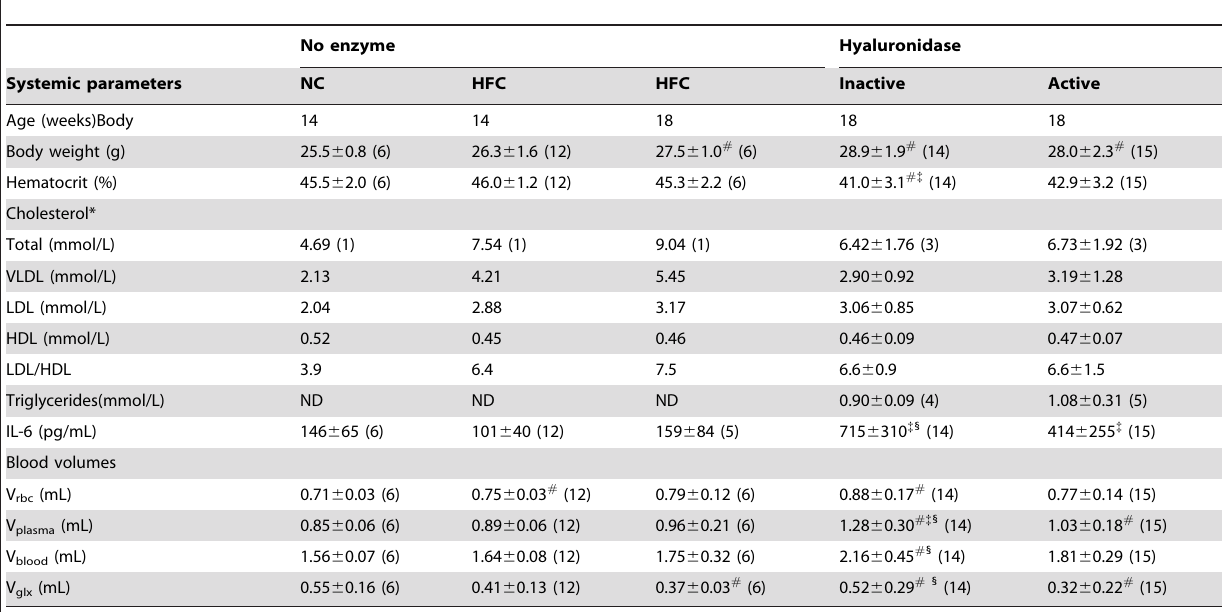
Table 1. Systemic parameters of apoE 2 / 2 mice on NC or HFC for 6- or 10 weeks w/o a final 4 week hyaluronidase infusion.